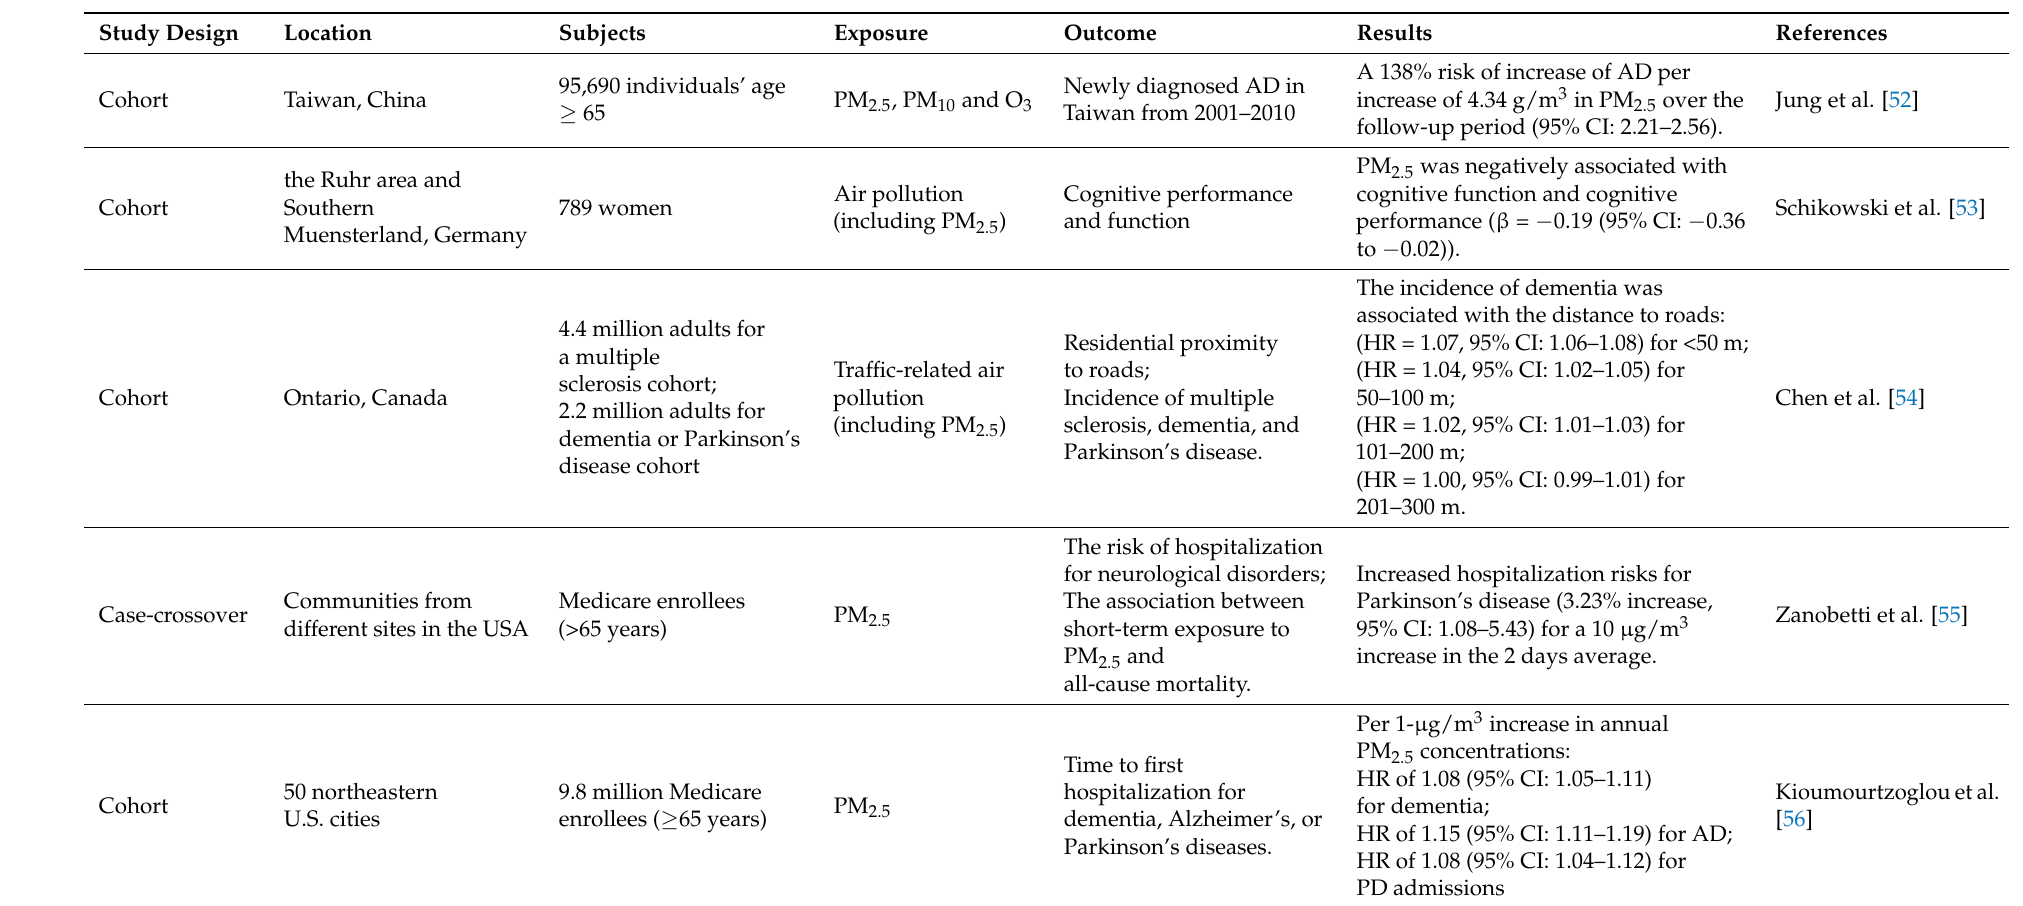
Table 1. Major evidence from epidemiological